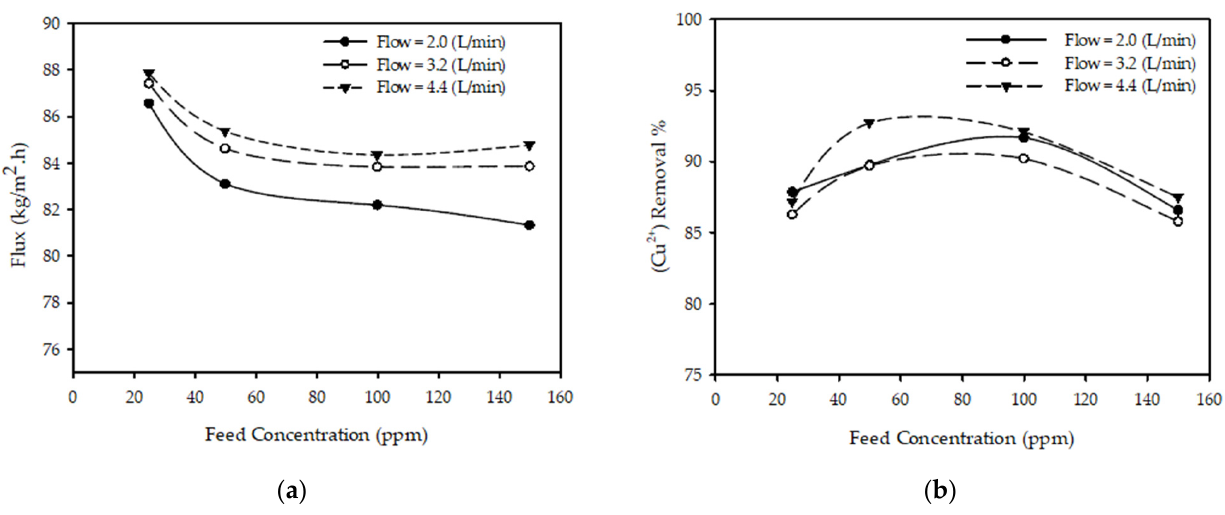
Figure 4. Effect of feed concentration on ( a ) permeate flux ( b ) (Cu 2+ ) removal % at feed flow rates for constant pressure 20 (bar) and temperature 25 °C.